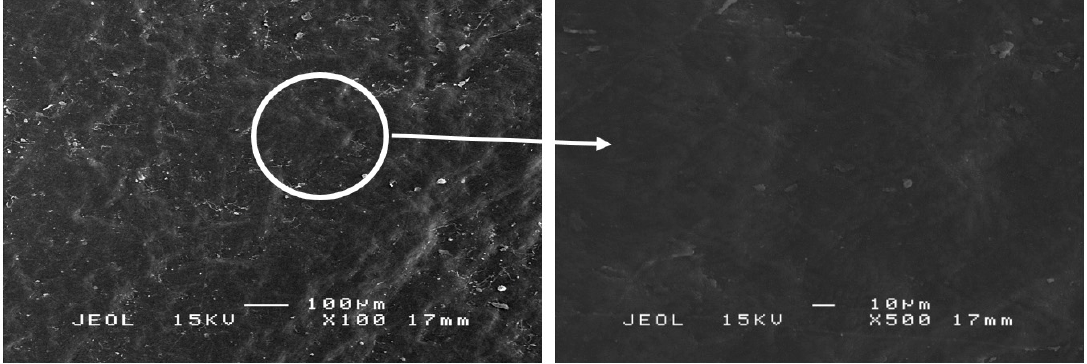
Figure 5. SEM micrographs of dry mangosteen leaves at 100× ( left ) and 500× ( right ) magnification.